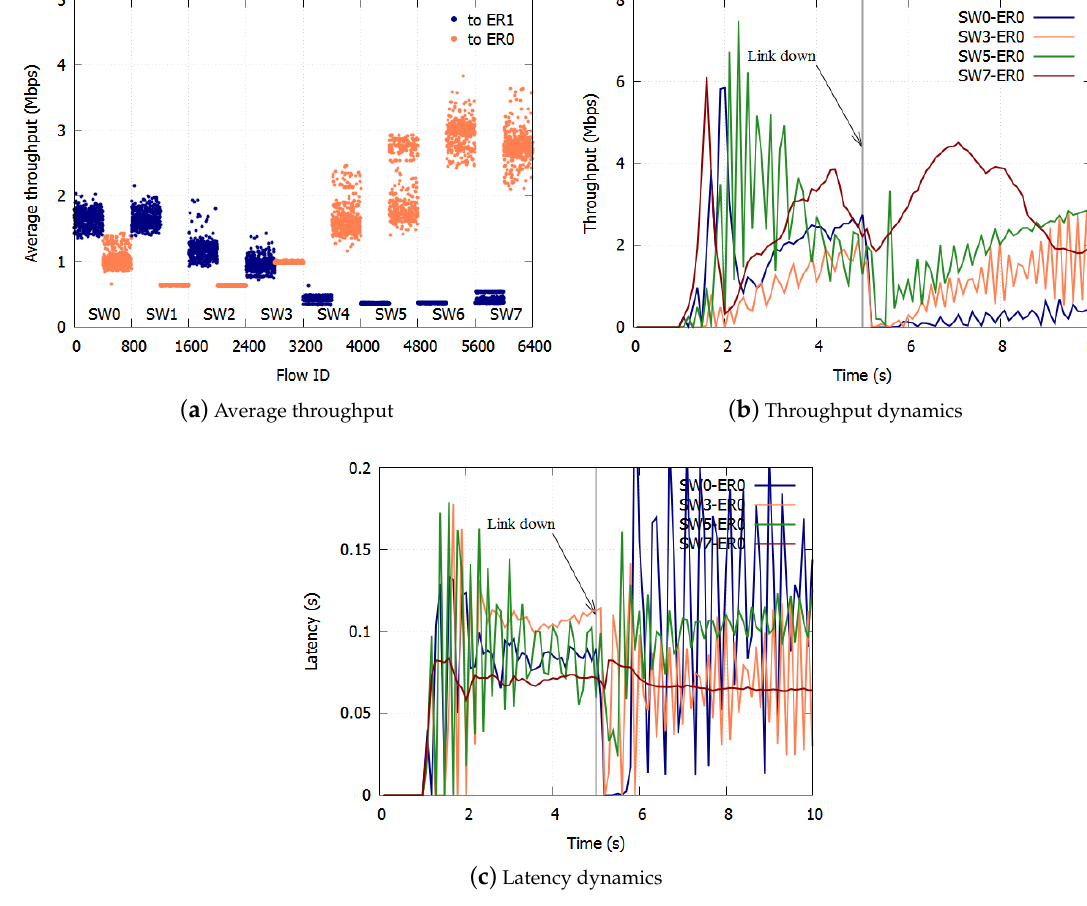
Figure 10. Result without